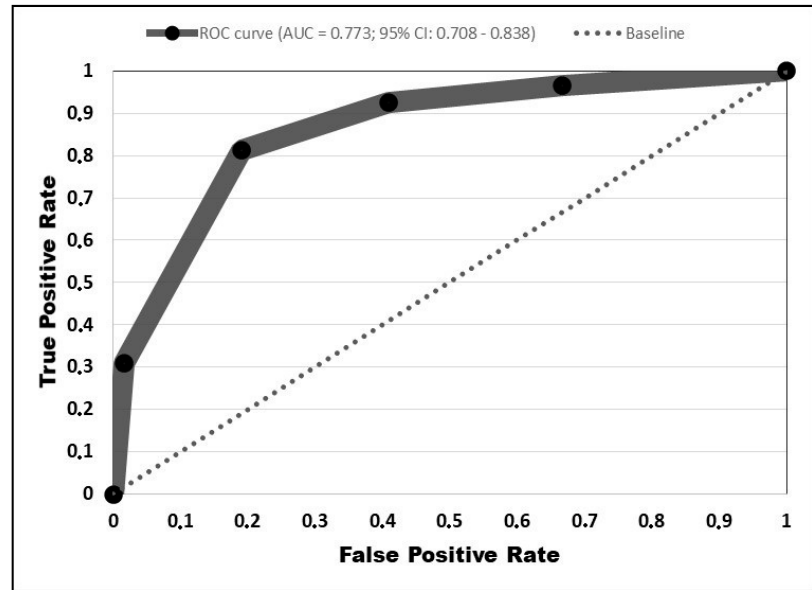
Figure 2. Receiver operating characteristic curve.